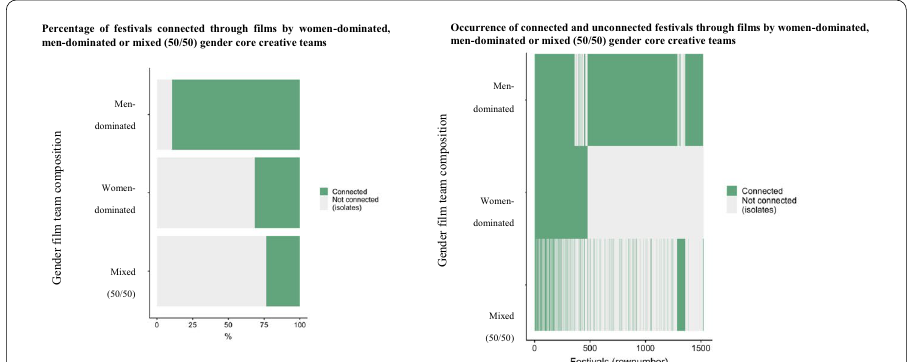
Fig. 13 Connectedness of festivals through women-dominated, men-dominated or mixed (50/50) core creative teams for second operationalization. Note : The left panel shows the percentage of isolated festivals for each gendered community. For example, only 479 out of all 1523 festivals are connected through films made by women-dominated core creative teams. This means that 69% of the overall festival network would count as isolates in the women-dominated community. The right panel shows the overlap of festivals through films made by women-dominated, men-dominated and mixed core creative teams. For example, the green pattern shows that most of the 479 festivals that are connected through films made by women-dominated core creative teams, are also connected through films made by men-dominated core creative teams (n 385), and through films made by mixed (50/50) core creative teams (n 194). 85 of these = = 479 festivals are exclusively connected through films made by women-dominated core creative